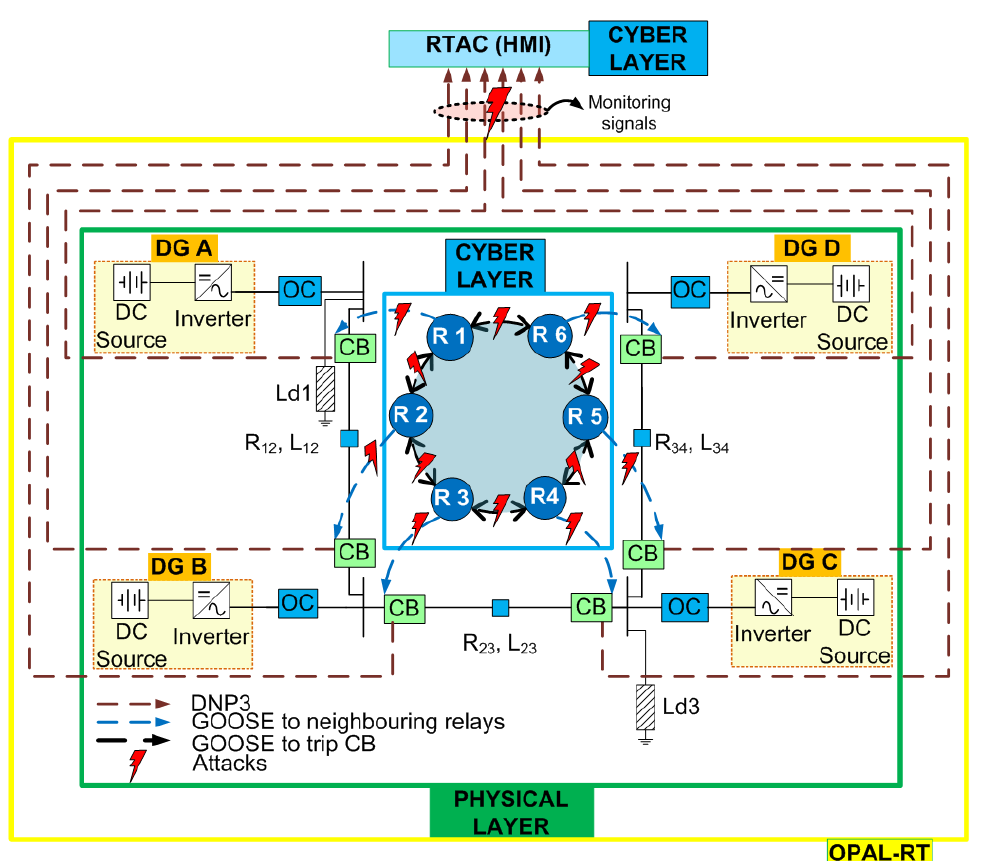
Figure 7. Protection network with communication